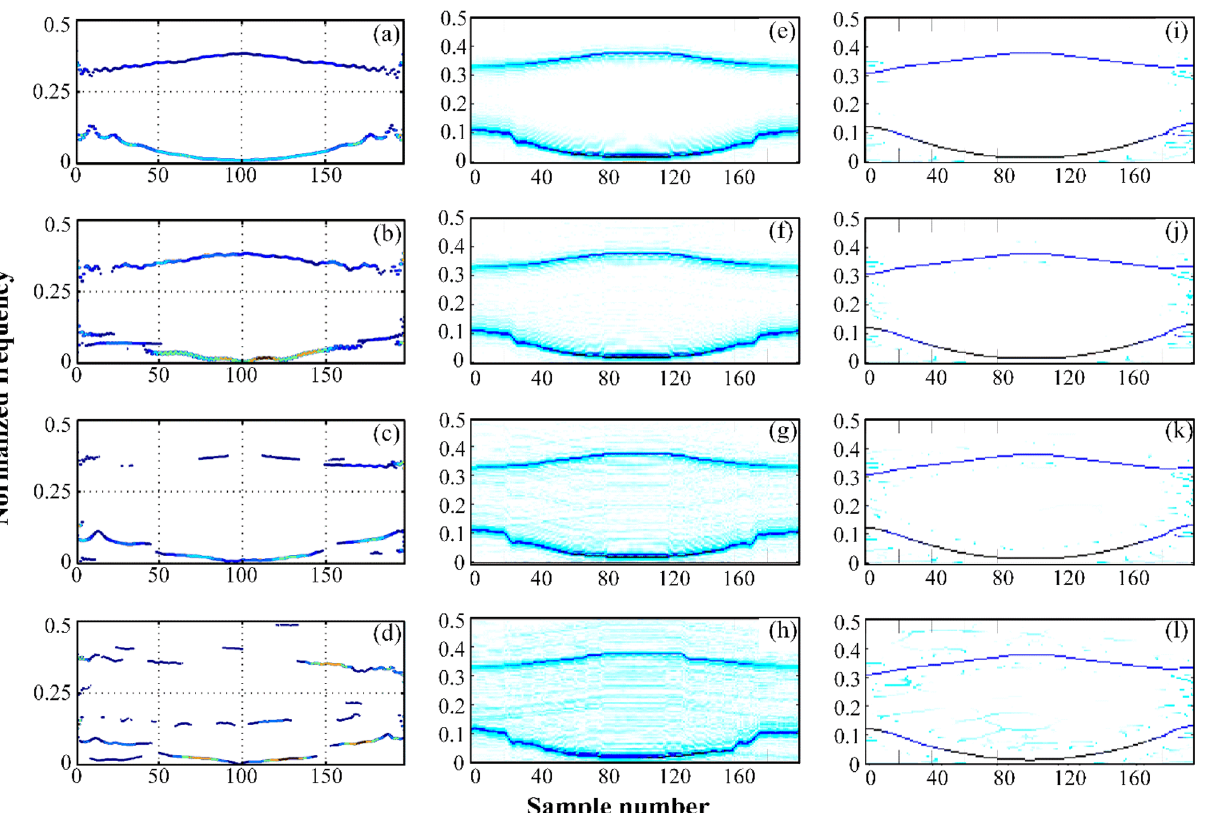
Figure 8. TFR of signal y4(n) using EVDHM–HT method, ( a ) Clean case, ( b ) SNR = 10 dB, ( c ) SNR = 5 dB, ( d ) SNR = 0 dB; using GWT method, ( e ) Clean case, ( f ) SNR = 10 dB, ( g ) SNR = 5 dB ( h ) SNR = 0 dB; using GWT– SSET, ( i ) Clean case, ( j ) SNR = 10 dB, ( k ) SNR = 5 Db, ( l ) SNR = 0